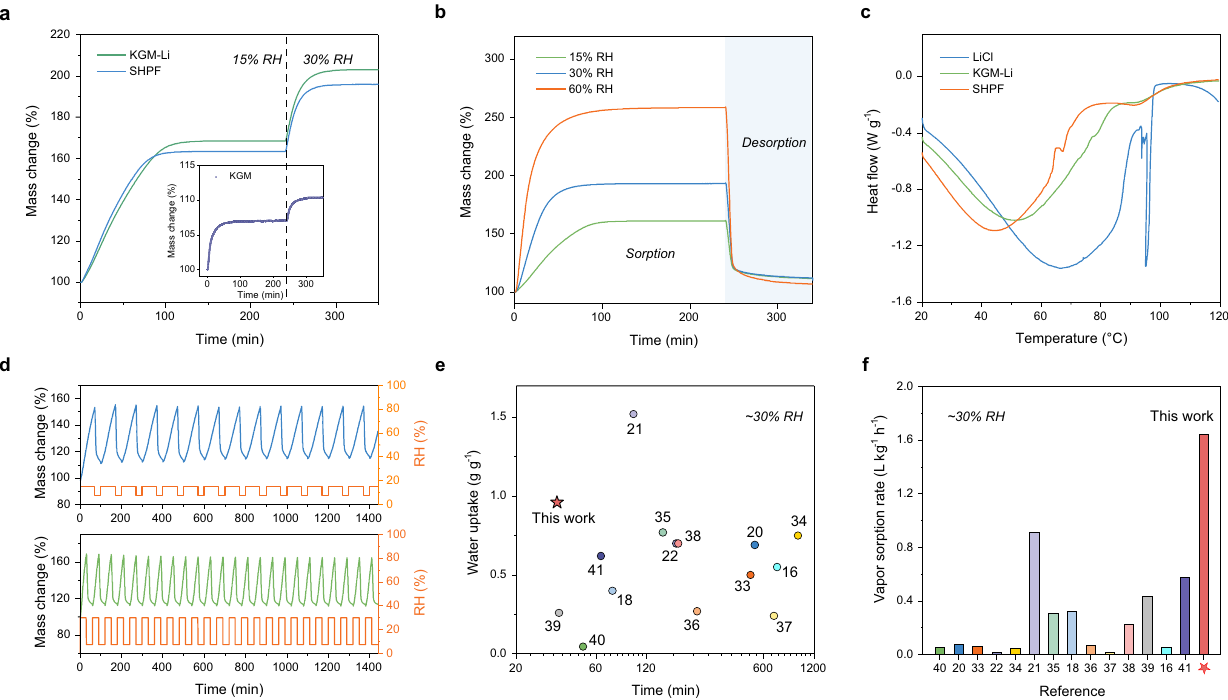
Fig. 3 Water vapor sorption-desorption performance of SHPFs. a Dynamic water vapor sorption process of KGM-Li, SHPF, and pure KGM (inset) at 25 °C, 15% RH and 30% RH. b Dynamic water vapor sorption-desorption processes of the SHPF at different conditions. c Evaporation behaviors of hydrated LiCl, KGM-Li fi lm, and SHPF. d Cycling performance of SHPFs, where sorption occurs at 15% RH (top: 100 min per cycle, 14 cycles per day) and 30% RH (bottom: 60 min per cycle, 24 cycles per day). The desorption is performed at 7.5% RH, 60 °C. e Comparison of water uptake and time required to reach 80% of the saturated water uptake with the state-of-the-art sorbent materials at ~30% RH. f Comparison of vapor sorption rate with the state-of- the-art sorbent materials at ∼ 30%